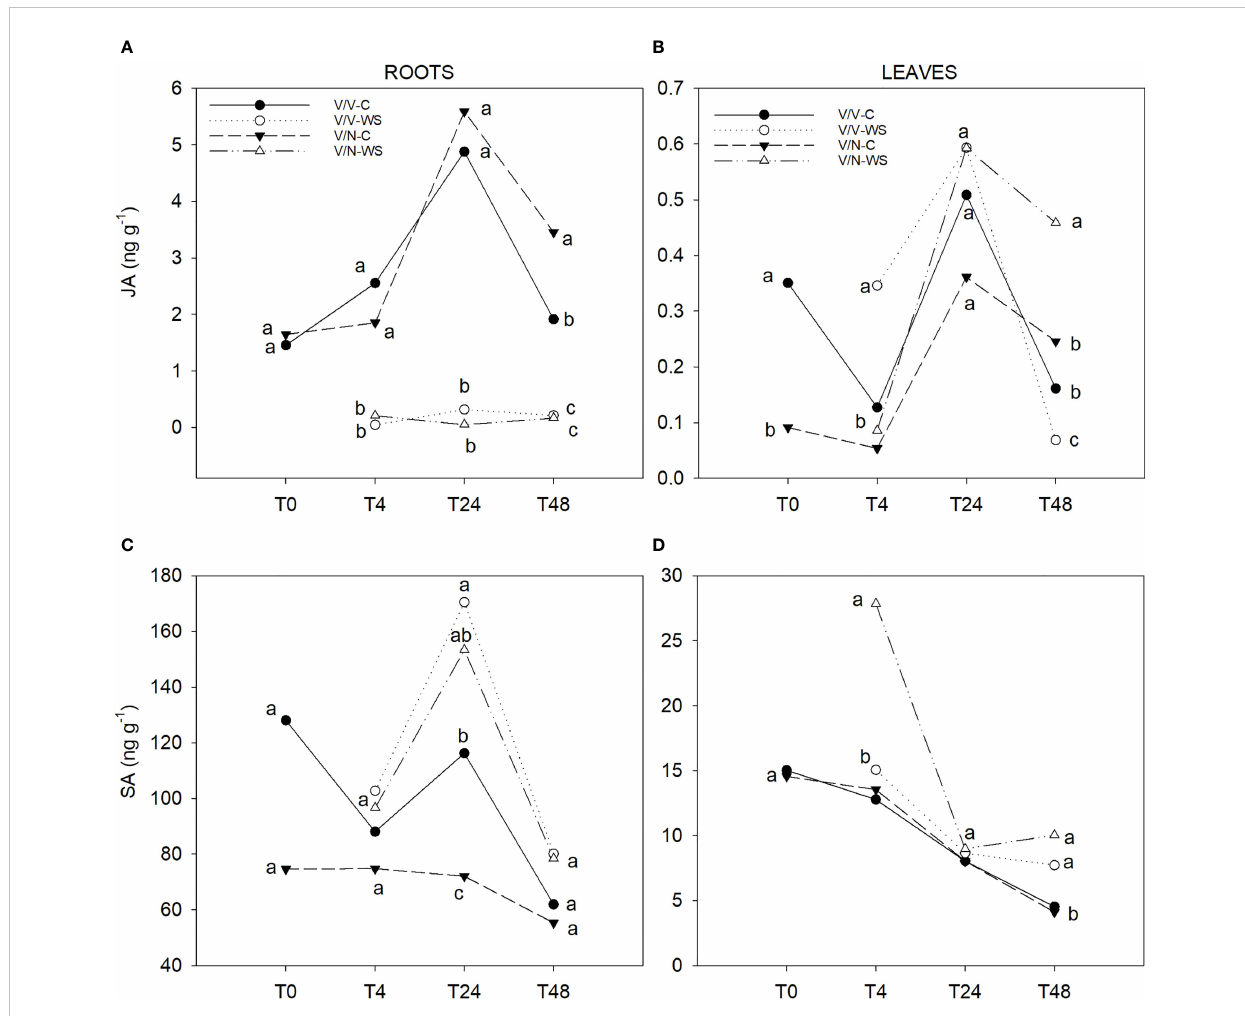
FIGURE 5 JA (A, B) and SA (C, D) levels in roots and leaves of self-grafted pepper plants (V/V) and the plants grafted onto NIBER ® (V/N) at 0% PEG (control, C) or 5% PEG (water stress, WS). Measurements were taken on T0, T4, T24 and T48 (hours after treatment with PEG began). Data are the mean values for n = 4. For each studied time, different letters indicate signi fi cant differences at P ≤ 0.05 (LSD